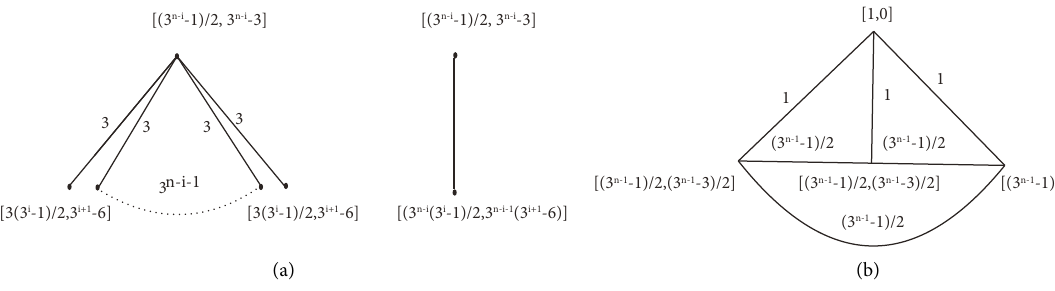
Figure 2: General case of quotient graph and reduced graph. (a) THT ( n ) / F